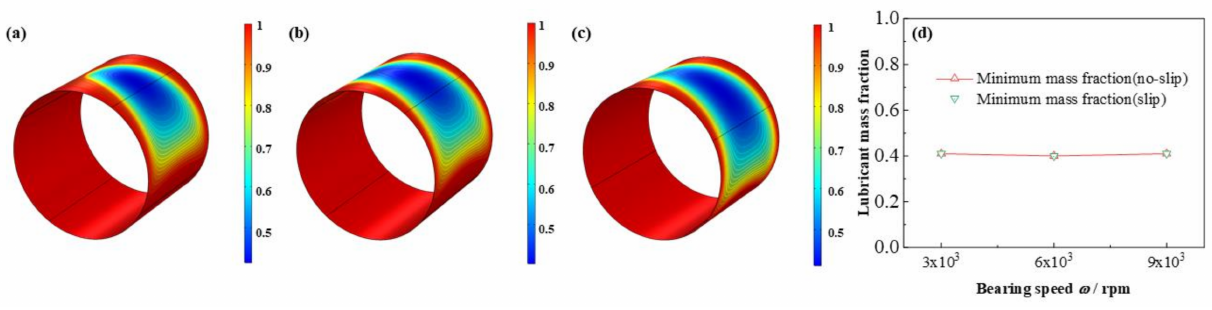
Figure 19. Comparison of the liquid mass fraction distribution under different bearing speeds. ( a ) ω = 3 × 10 3 rpm;